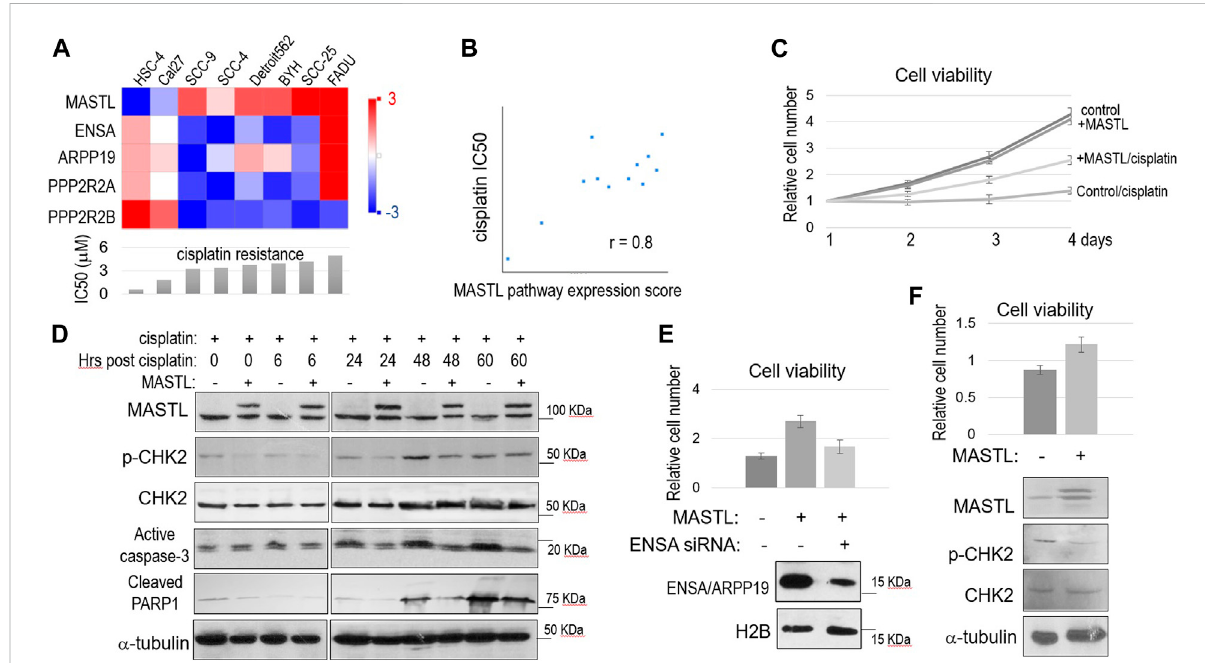
FIGURE 2 The MASTL-ENSA/ARPP19-PP2A/B55 pathway mediates cisplatin resistance in OSCC. (A) The expression levels of MASTL, ENSA, ARPP19, PPP2R2A, and PPP2R2B in various OSCC cell lines were obtained, and shown in the heatmap graph, as described in Materials and Methods. The IC50 of cisplatin was shown in the below panel. (B) The expression levels of MASTL, ENSA, ARPP19, PPP2R2A, and PPP2R2B in OSCC cell lines were obtained as in panel (A) . The MASTL pathway expression score was calculated by MASTL + ENSA + ARPP19-PPP2R2A-PPP2R2B (log2 values), and correlated with cisplatin IC50 values, as described in Materials and Methods. (C) Cell viability assay was performed as in Materials and Methods. SCC38 cells with or without stable expression of CFP-MASTL were incubated with cisplatin (3.3 μ M) from day 1. The cell numbers at days 2 – 4 were normalizedtothatatday1(untreated).Themeanvaluesandstandardderivations,fromthreeindependentexperiments,wereshown. (D) SCC38cells without or with stably expression of CFP-MASTL were treated with cisplatin (5 μ M) for 2 h, and allowed for recovery for the indicated numbers of hours.Cellswereharvestedandanalyzedbyimmunoblotting, usingtheindicatedantibodies. (E) SCC38cellswithorwithoutCFP-MASTLexpression or ENSA siRNA-treatment were cultured in the presence of cisplatin (3.3 μ M). After 3 days of cisplatin treatment, cell viability was measured, as in panel (C) . Mean values and standard deviations were calculated from three independent experiments, and shown in the upper panel. The effect of ENSA knockdown was shown by immunoblotting, in the lower panel, using antibodies that recognize H2B and both ENSA/ARPP19. (F) Cal27 cells transfected with control GFP or GFP-MASTL expression vectors were treated with cisplatin (3.3 μ M). The cell viability after 2 days incubation was determined, and normalized to that of pre-treatment. The mean values and standard deviations were calculated from three independent experiments, and shown in the upper panel. Cells were analyzed by immunoblotting using the indicated antibodies, and shown in the lower